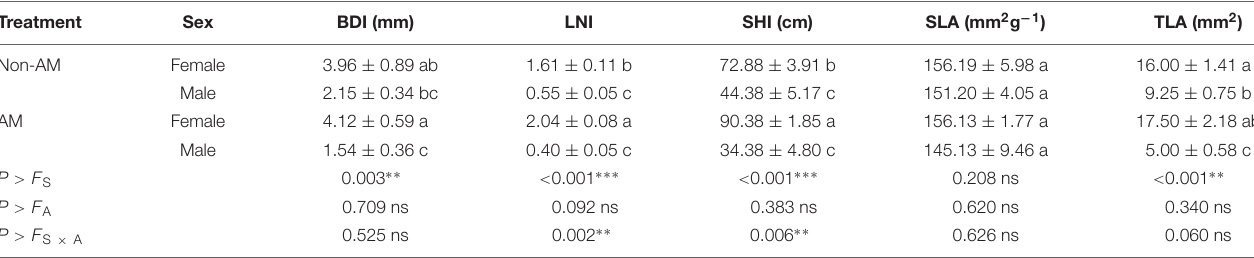
TABLE 1 | The basal diameter increment (BDI), leaf number increment (LNI), shoot height increment (SHI), specific leaf area (SLA), and total leaf area (TLA) in female and male Populus cathayana saplings as affected by arbuscular mycorrhizal (AM) fungi.